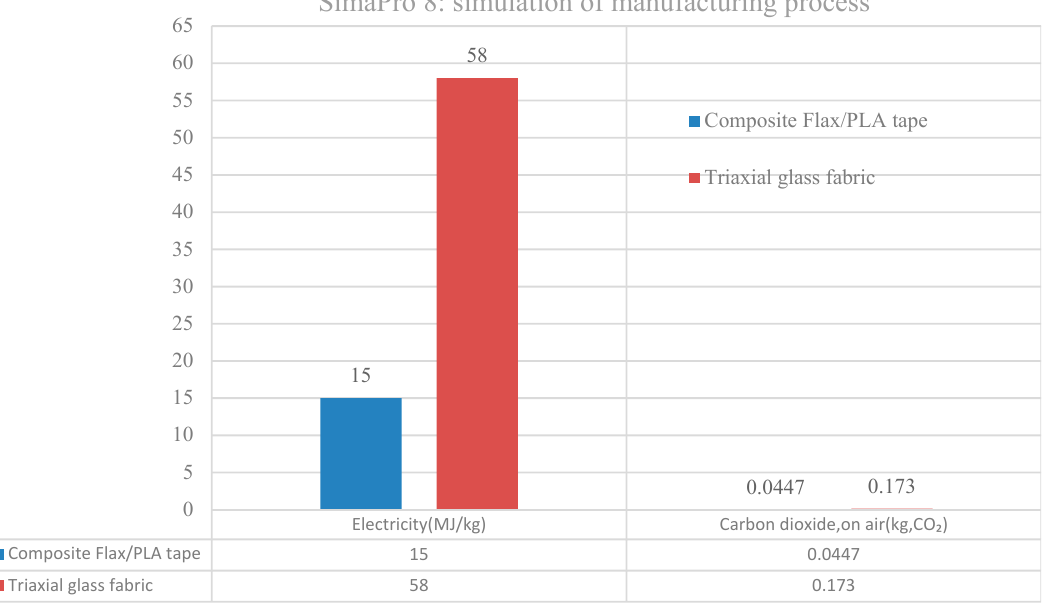
Figure 9. The simulation result of the SimaPro 8 simulation for the production of composite materials.